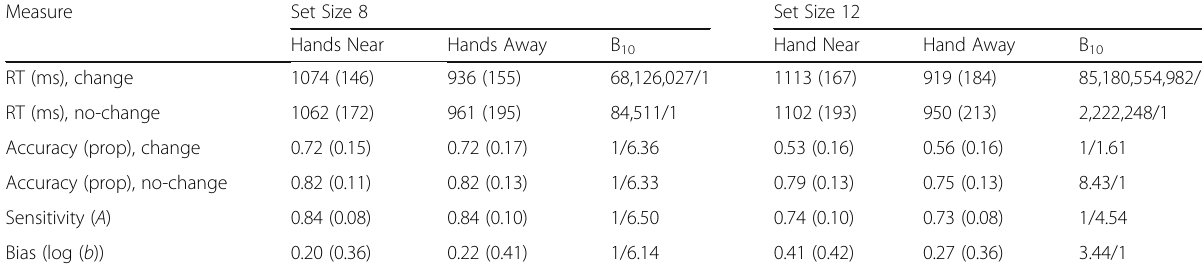
Table 2 Means, standard deviations, and Bayes factors (B 10 ) for each condition in Experiments 3 Measure Set Size